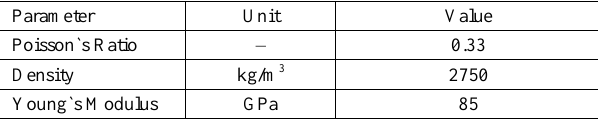
Table 2. Material properties accepted for calculation for material 42CrMn04+ Parameter Unit